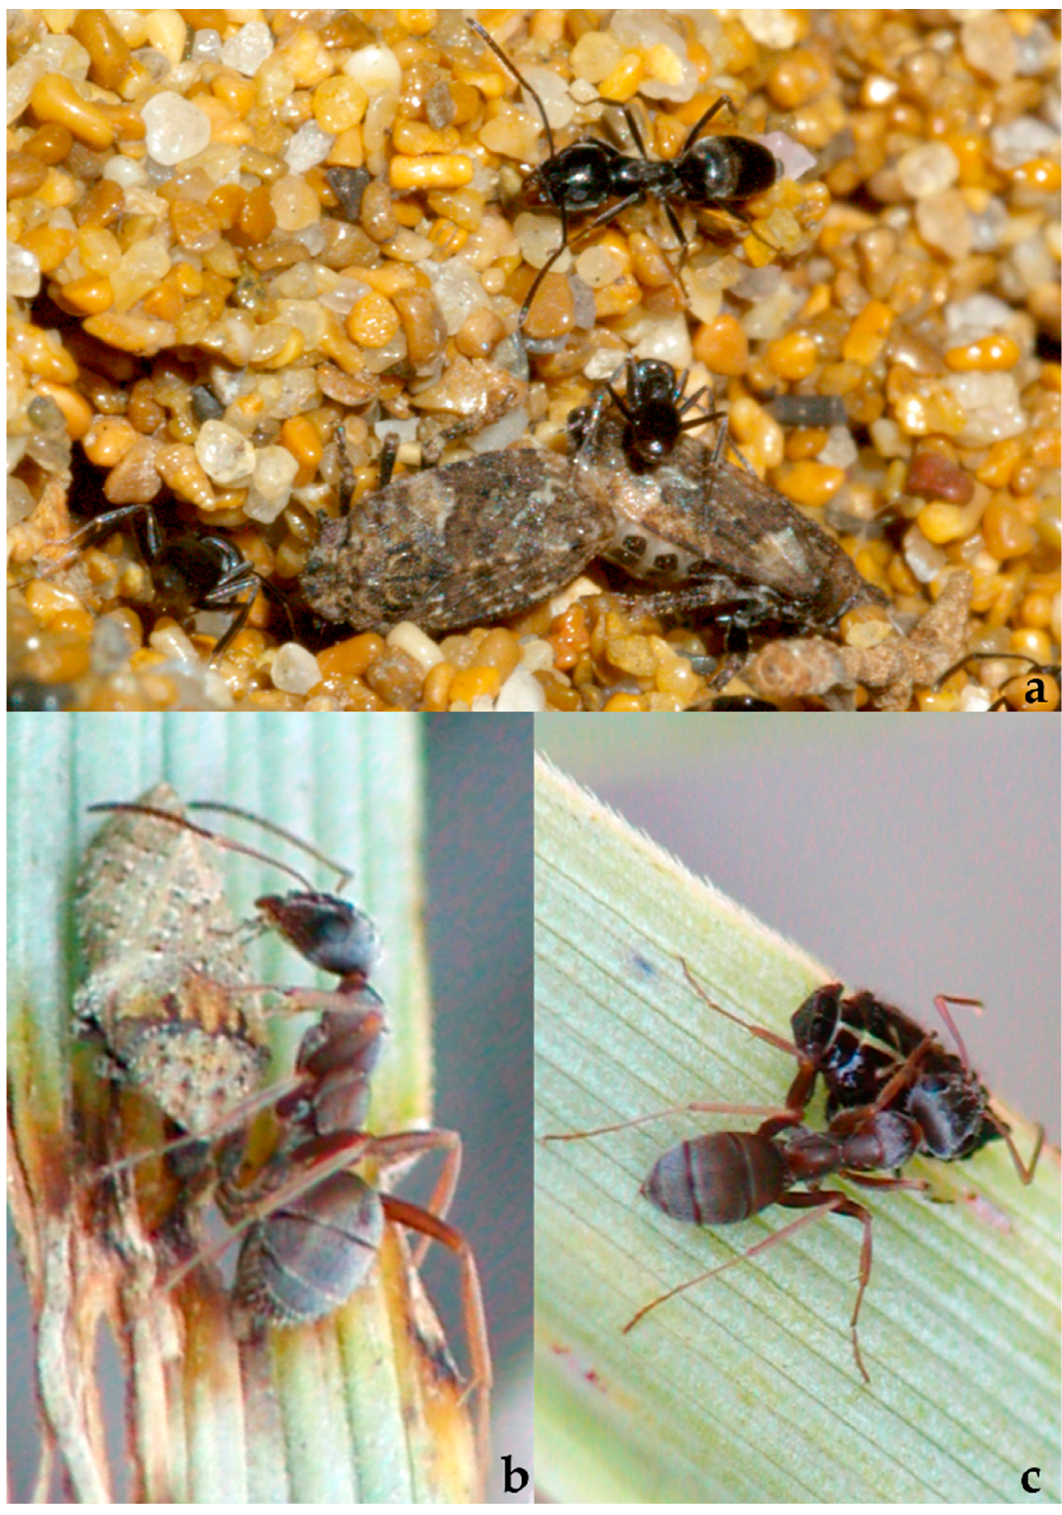
Figure 33. Tettigometridae: ( a ) Tettigometra ( Mitricephalus ) griseola Fieber, 1864 tended by Formici- dae: Dolichoderinae: Tapinoma sp., Italy: Calabria, Capo Colonna, 39°0 ′ 46 ″ N 17°10 ′ 49 ″ E, 27.04.2008, nymphs and adults on Cakile maritima Scopoli (Brassicaceae), obs. I. Gjonov, A. Lapeva-Gjonova; ( b , c ) T. ( Mitricephalus ) leucophaea (Preyssler, 1792) tended by Formicidae: Formicinae: Formica cinerea Mayr, 1853, Bulgaria: Northern Black sea coast, Kamchiya river mouth, 43°01 ′ 56.0 ″ N 27°53 ′ 17.9 ″ E, 24.06.2004, nymphs and adults on Ammophila arenaria (L.) (Poaceae), obs. I. Gjonov, A. Lapeva- Gjonova.